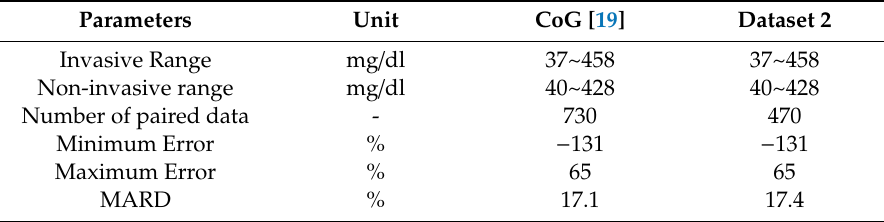
Table 6. Baseline dataset 2.